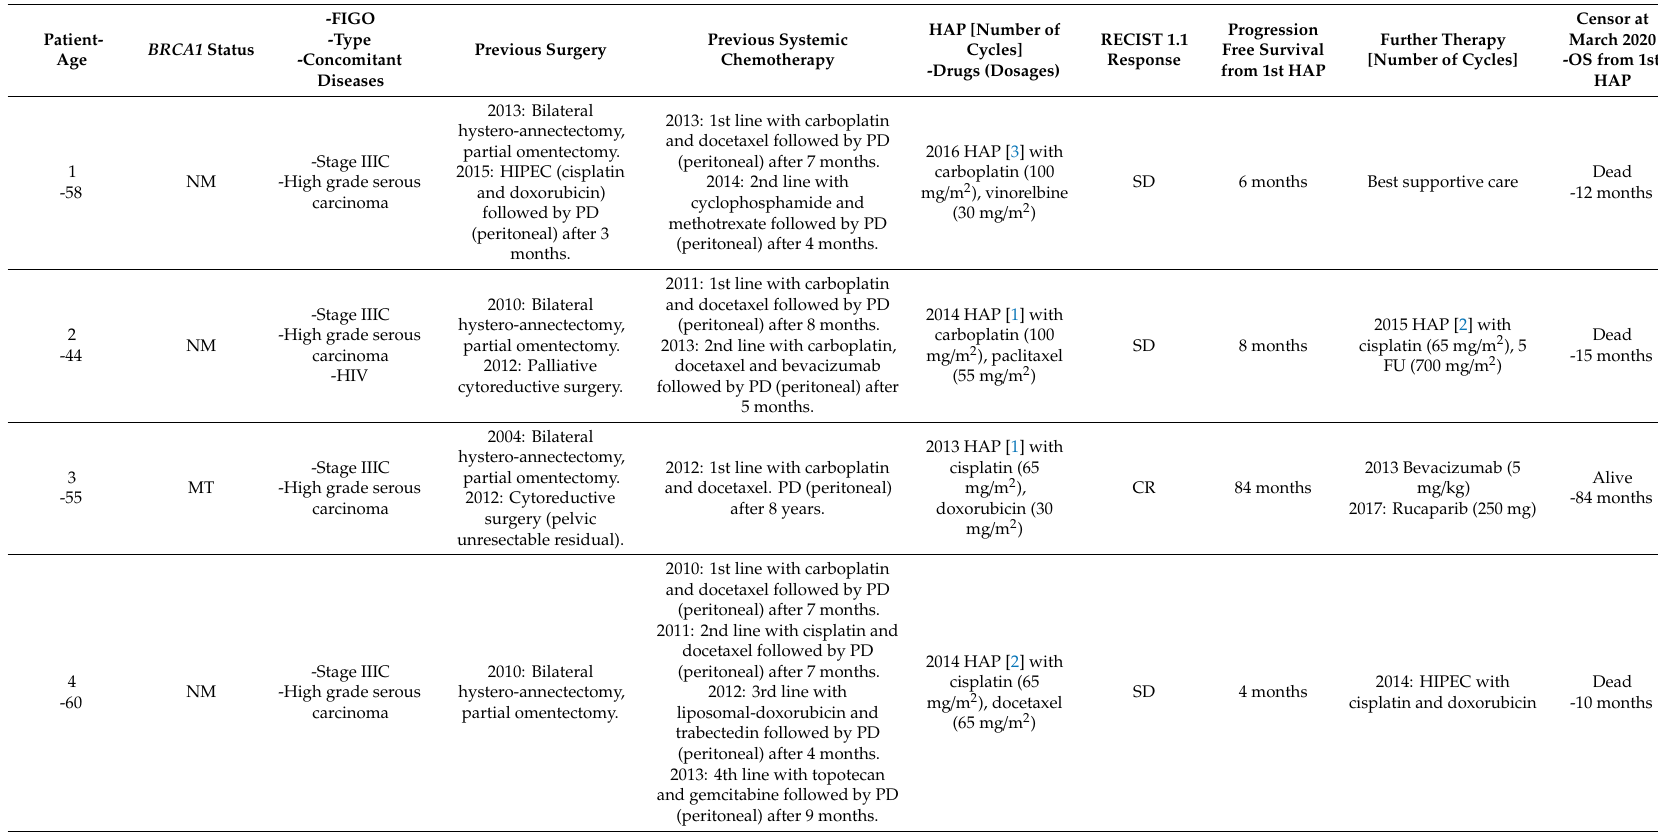
Clinical characteristics, RECIST 1.1 tumour responses, and survival of 10 advanced epithelial ovarian cancer (EOC) patients submitted for multidisciplinary